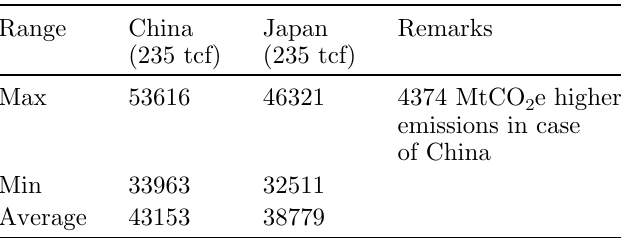
Table 3. Total emissions from extraction to power e) for 235 tcf of shale gas. generation (MtCo 2